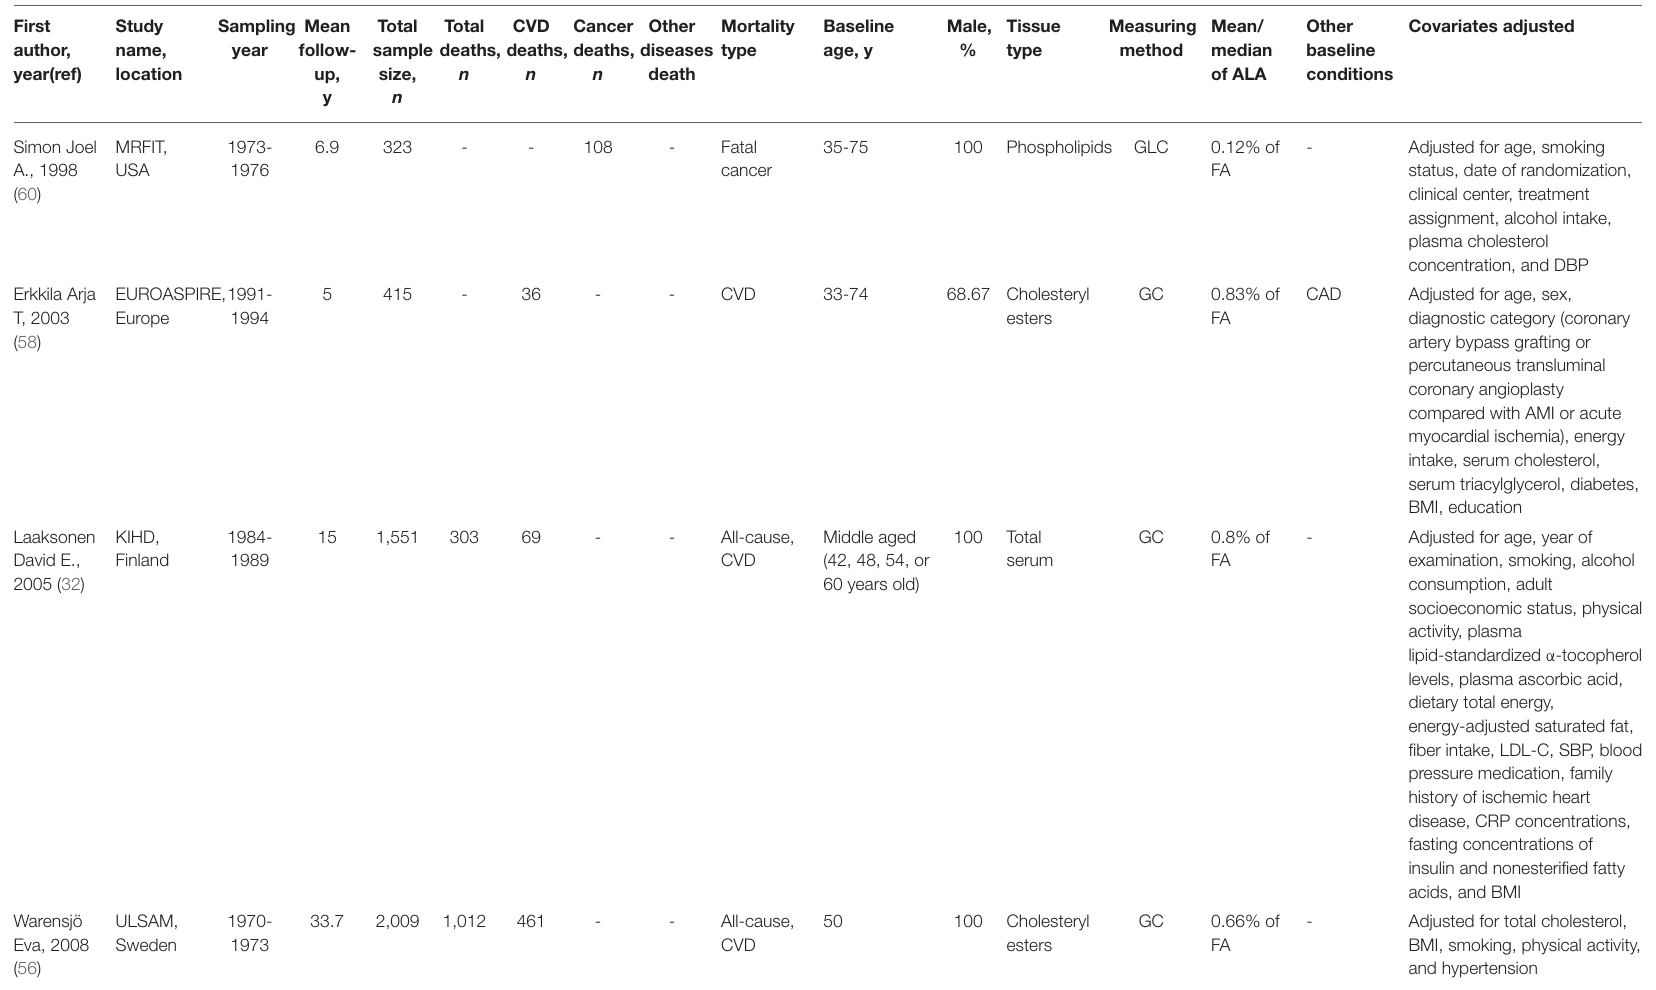
TABLE 2 | Characteristics of prospective cohort studies that evaluated the association between biomarkers of ALA in body tissues and mortality from all-cause, CVD and other